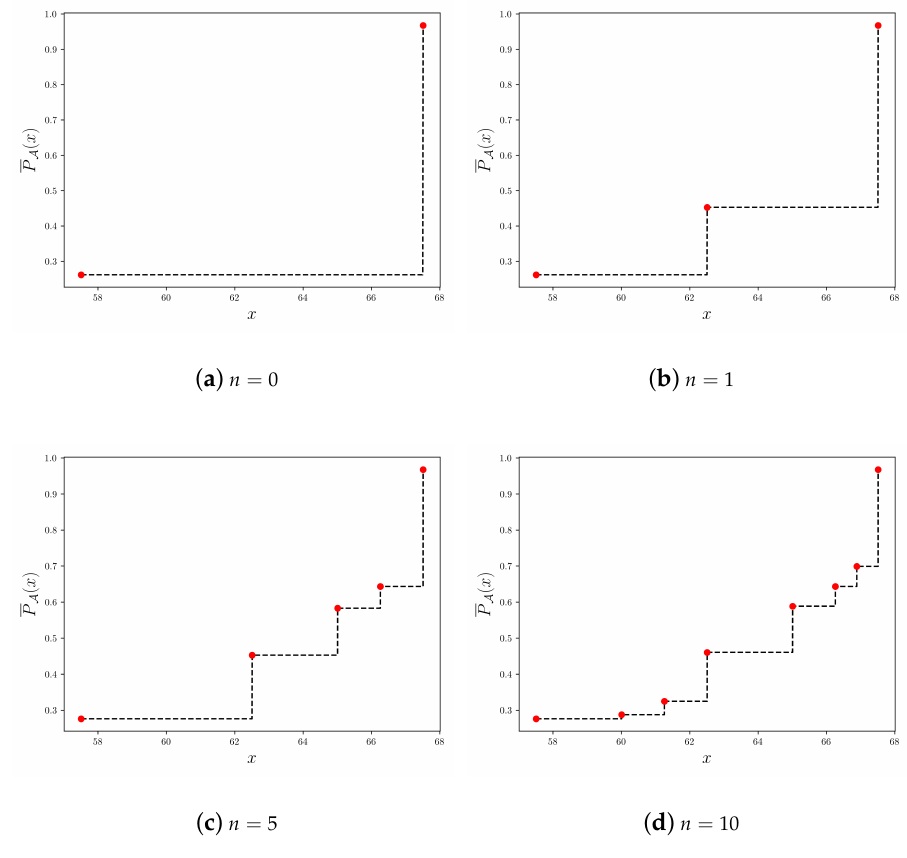
Figure 10. Evolution of P A ( x ) as function of the iteration count, n